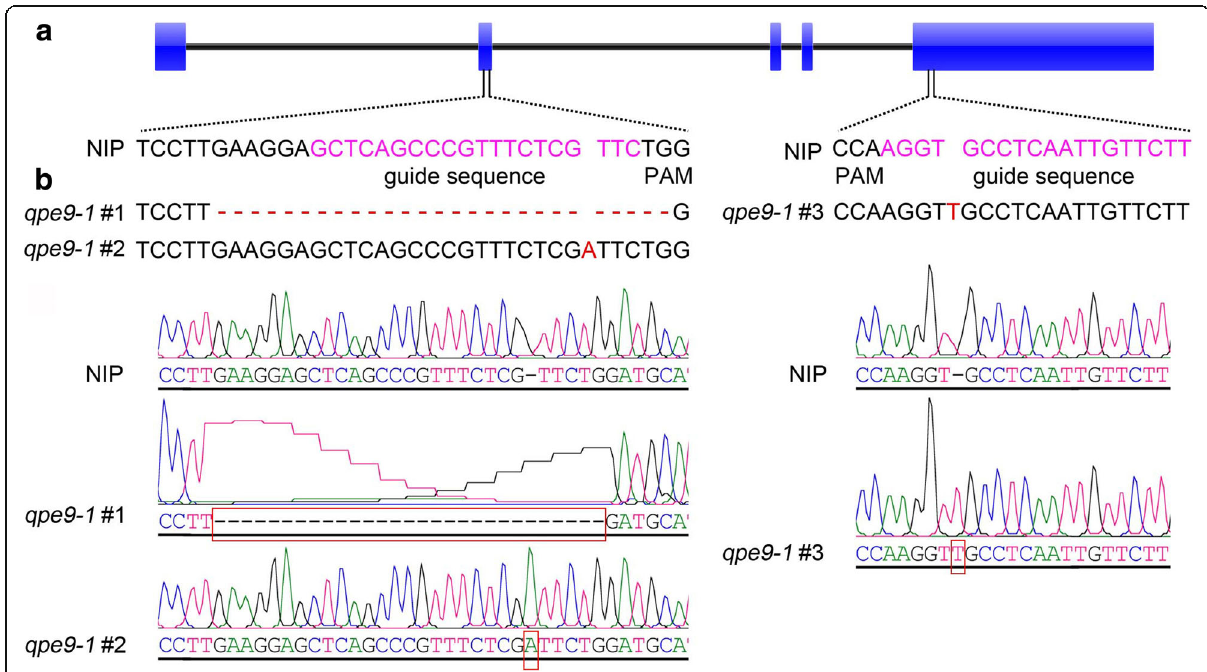
Fig. 1 Identification of the three qpe9 – 1 mutants generated using CRISPR/Cas9. a Two specific target guide RNA sequences located in the second and fifth exons were selected to edit qPE9 – 1 . Target guide sequences are marked in pink. b The mutation sites of qPE9 – 1 in the three mutants, qpe9 – 1#1 , qpe9 – 1#2 , and qpe9 – 1#3 , were confirmed by sequencing. Base variation is shown by the red